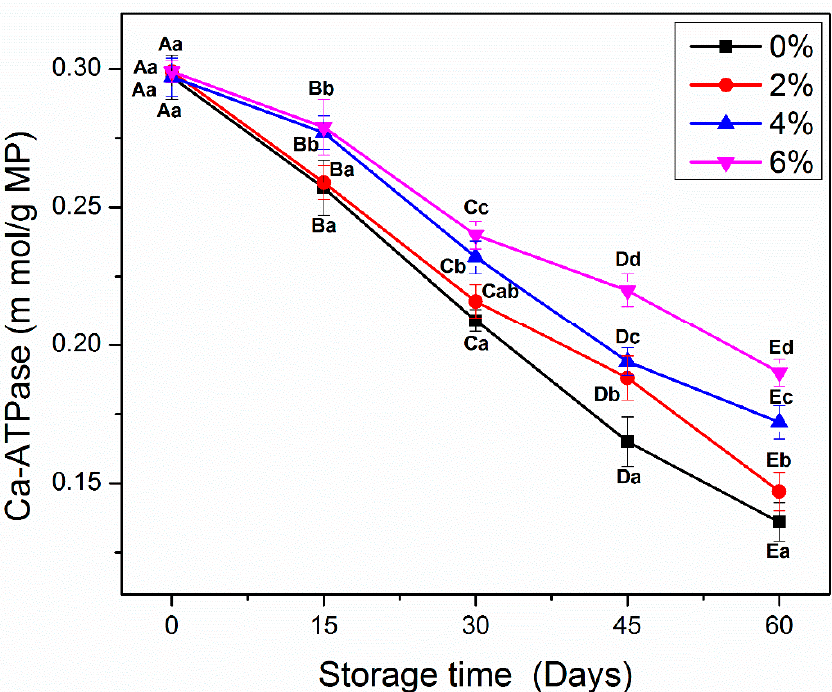
Figure 2. Ca 2+ -ATPase activity of myofibrillar protein treated with different concentrations of OVA-KC during 60 days of frozen storage at − 18 °C. Capital letters (A–E) refer to the significant differences in similar treatments within the different storage times ( p < 0.05). Lowercase letters (a–d) refers to the significant difference in the same frozen storage period of different concentrations ( p < 0.05).